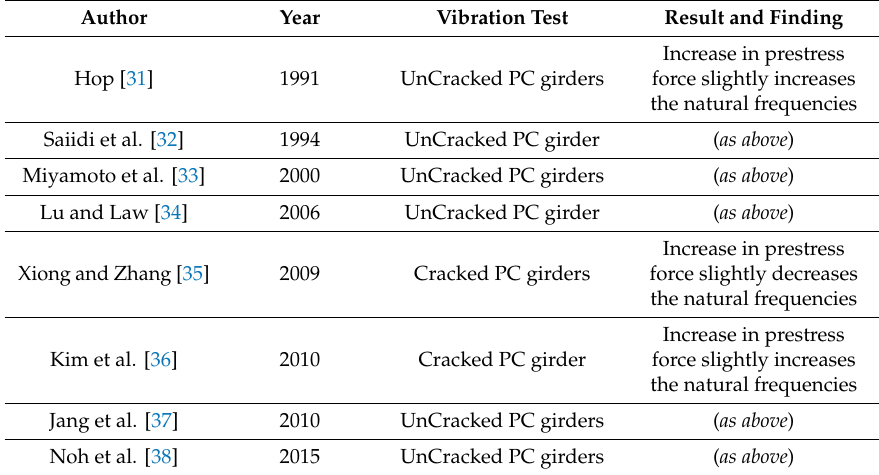
Table 1. Laboratory investigations on the relation between prestress force and dynamics of Prestressed Concrete (PC)